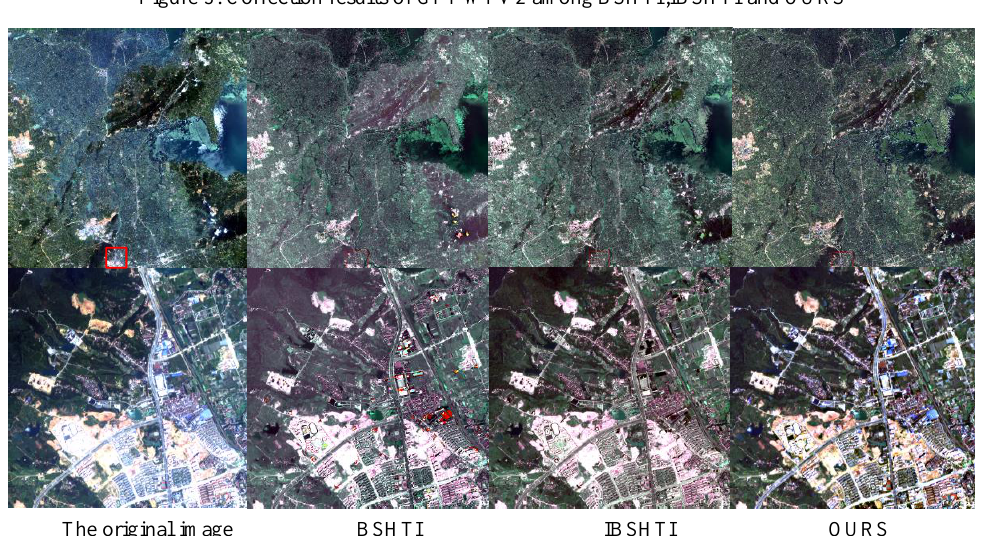
Figure 4. Correction results of GF1-PMS1 among BSHTI,IBSHTI and